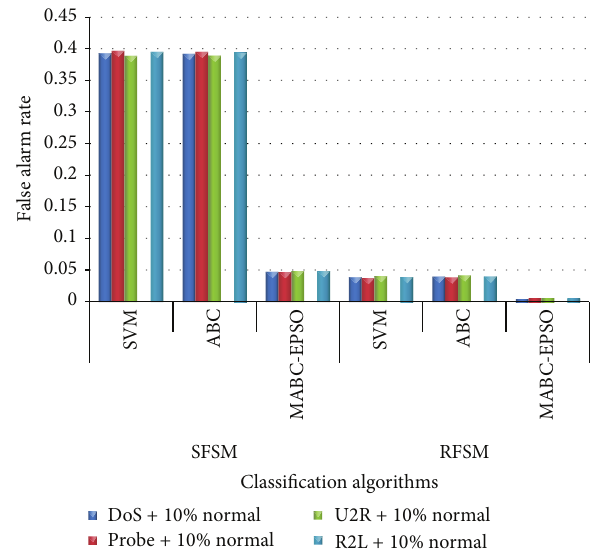
Figure 10: Comparison on specificity using RFSM method.